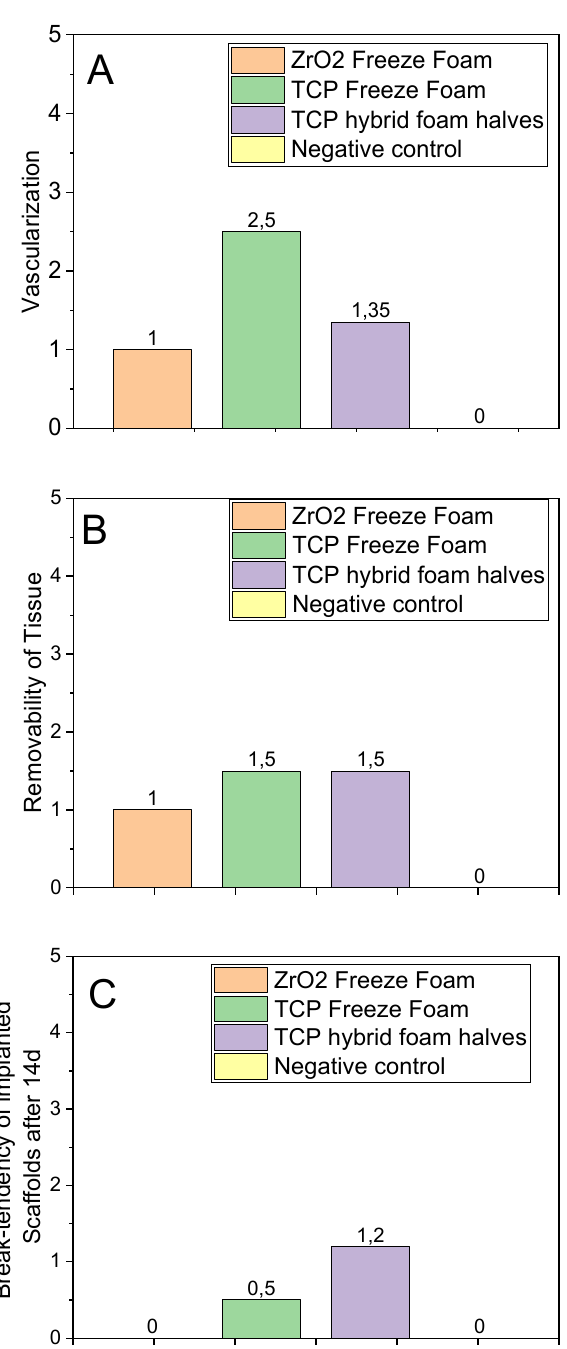
Figure 19. Implant parameters after 14 days: ( A ) tissue adherence/ingrowth into the artificial bones; ( B ) removability of tissue from the implants; ( C ) break-tendency of implanted scaffolds.